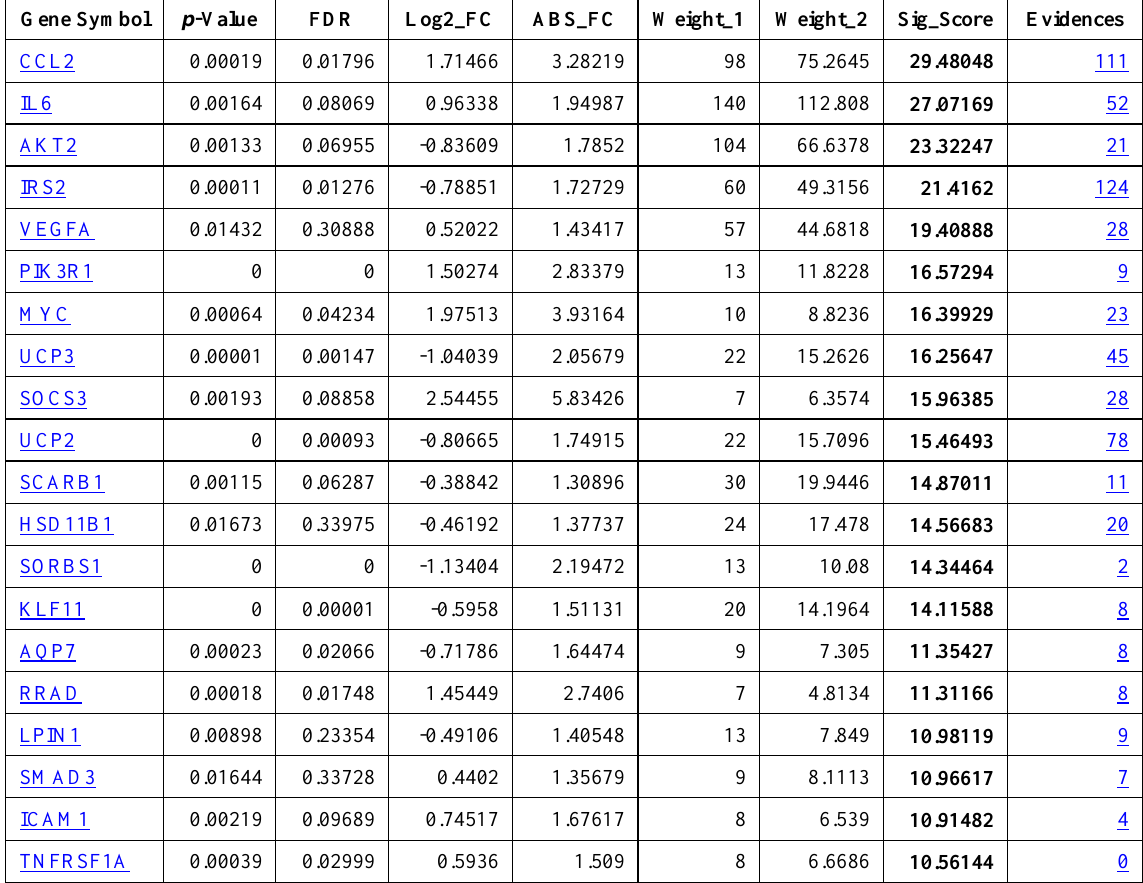
Table 2: Top-20 significant genes in IBB from GSE24215, ordered by Sig_Score, which is measured in the T2D-specific PPI network (PubMed >=0, h-Score >=0.45) for all the differential genes (FC>=1.3, p-value <=0.05 and AEL >=40% after applying Limma package in Bioconductor) in IBB from